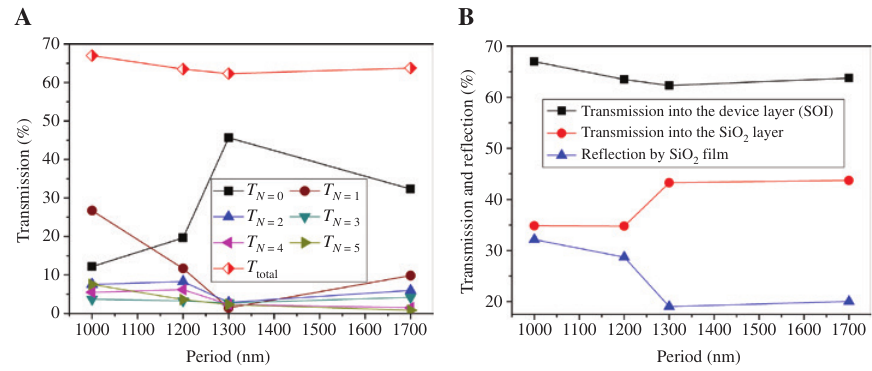
Figure 3: Calculated transmission properties of photon-trapping holes and back reflection by SiO 2 (A) RCWA calculated total transmission ( T ) and transmission diffraction efficiency ( T ) from hole-based i -Si layer to the SOI device layer total N with the order from N = 0 to N = 5 versus period (in the x direction) for hexagonal hole array with a diameter of 700 nm on Si substrate. (B) RCWA calculated total transmission into the device layer of SOI, total reflection by the SiO film, and total transmission into the SiO film 2 2 of incident light versus period (in the x direction) for hexagonal hole array with a diameter of 700 nm on an SOI substrate. Note that the calculation is for cylindrical